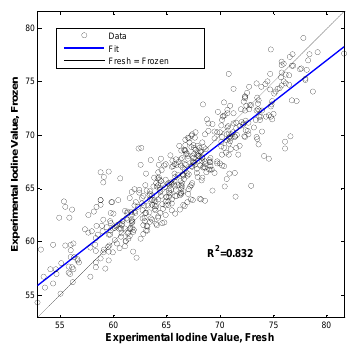
Fig. 6 Fresh vs. Frozen Iodine value, determined by GC, validation